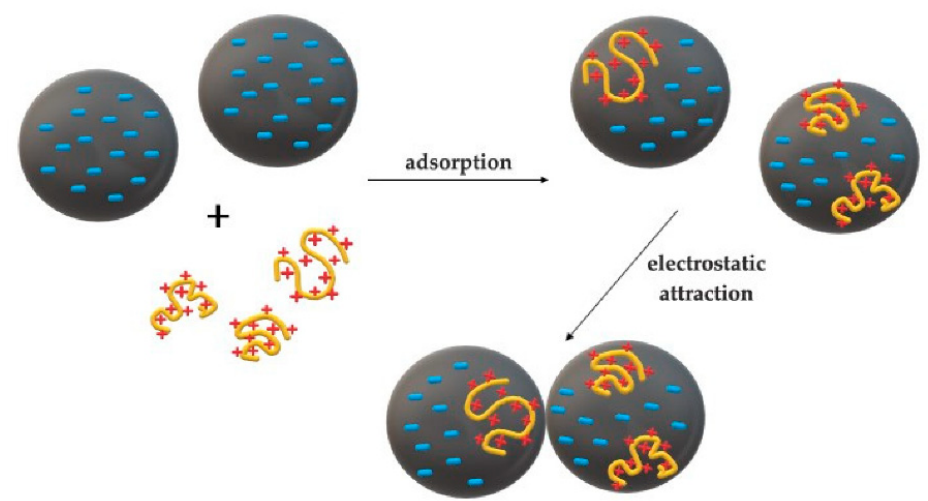
Figure 5. Charge ‐ patch mechanism for cationic polymers according to Ma ć czak et al. (2020) [99]. Figure 5. Charge-patch mechanism for cationic polymers according to Ma´cczak et al. (2020)